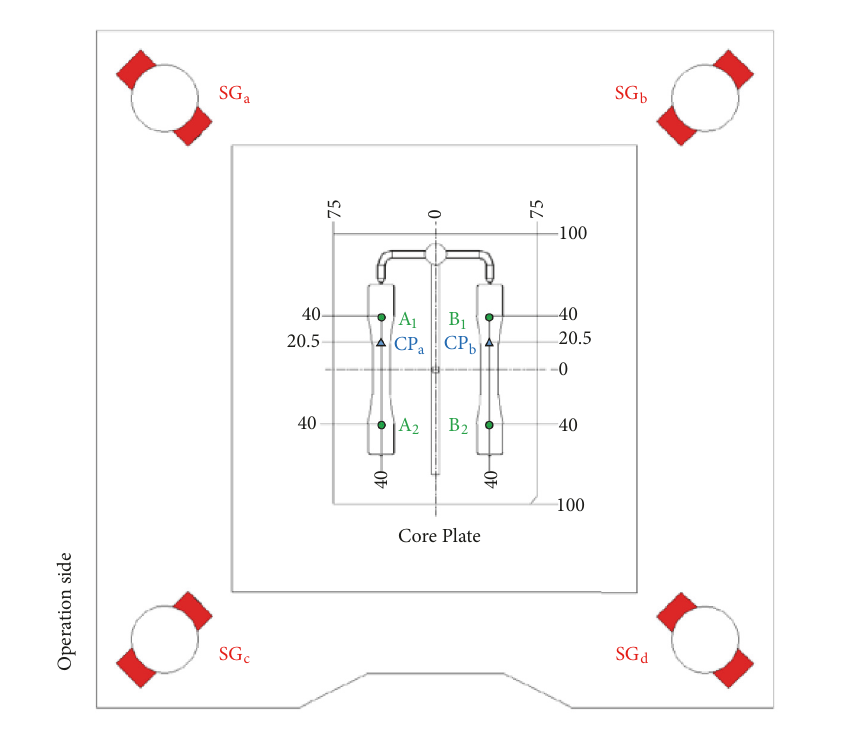
Figure 7: Detailed arrangement of cavity sensors ( 𝐶𝑃 𝑎 − 𝐶𝑃 𝑏 ) and strain gauge sensors ( 𝑆𝐺 𝑎 − 𝑆𝐺 𝑑 ).